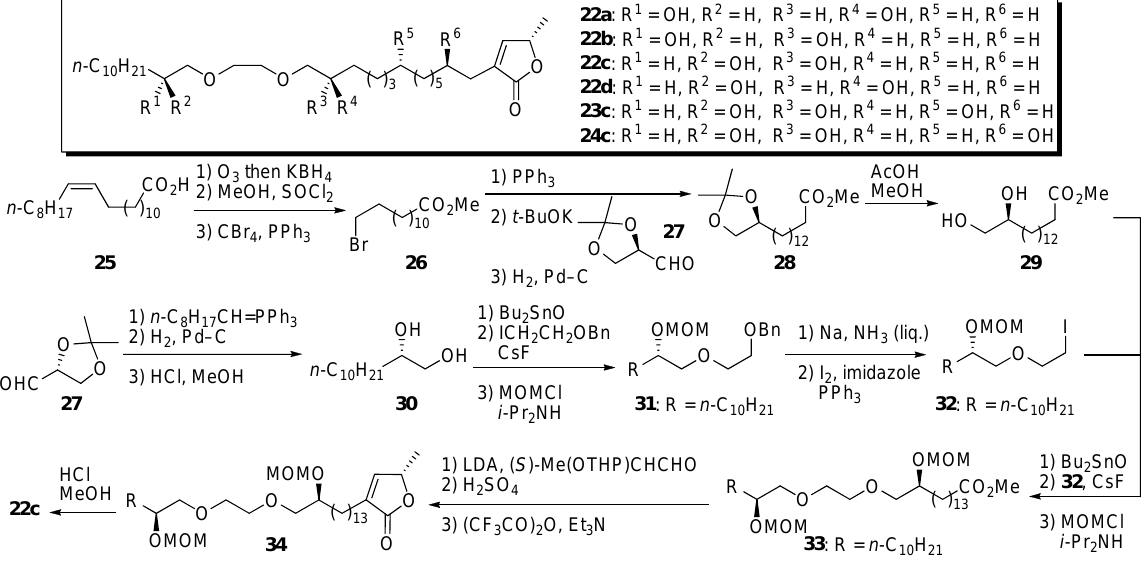
Table 3. Cytotoxicity against human solid tumor cell